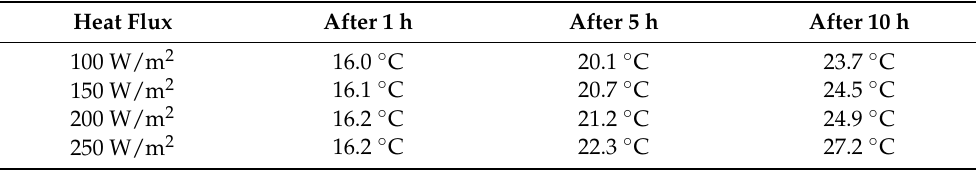
Table 1. The average temperature on the surface of the wall for CW01.